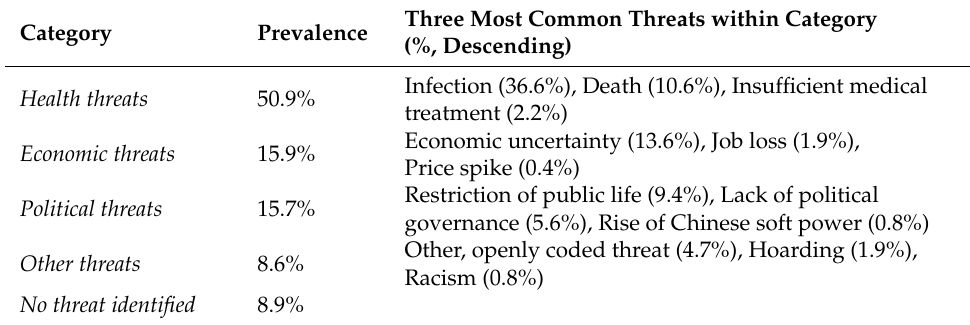
Table 2. Overview of Different